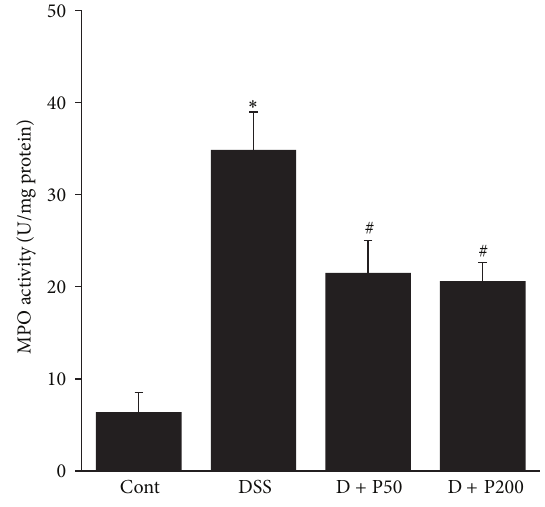
Figure 5: MPO activity in a 𝛾 -PGA-treated DSS-induced colitis model. Control group (without DSS; Cont), 3% DSS administration group (DSS), 3% DSS with 𝛾 -PGA at 50 mg/kg body weight per day (D + P50), 3% DSS with 𝛾 -PGA at 200 mg/kg body weight per day (D + P200). Data shown represent the results of 3 independent experiments, expressed as mean ± SD ( 𝑛 = 8 per group). ∗ 𝑃 < 0.05 , DSS versus Cont; # 𝑃 < 0.05 , D + P50 and D + P200 versus